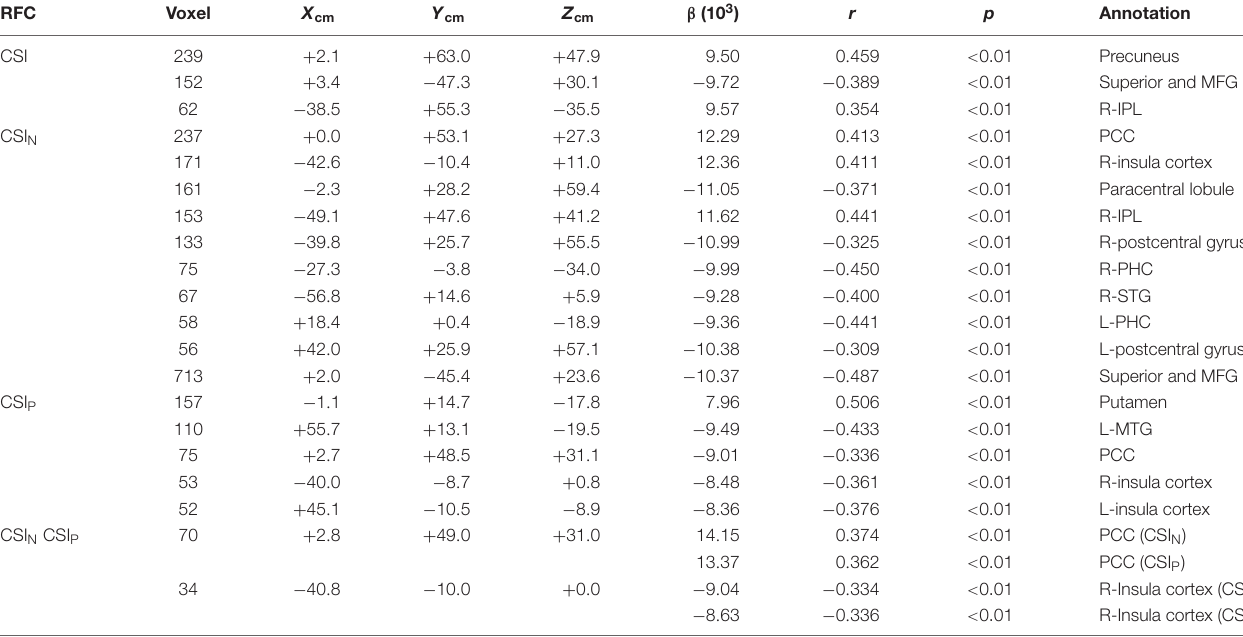
TABLE 1 | The brain regions where the connectivity strength metrics are significantly ( p < 0.05) correlated with the subjects’ ages. RFC Voxel X cm Y cm Z cm β (10 3 ) r p Annotation